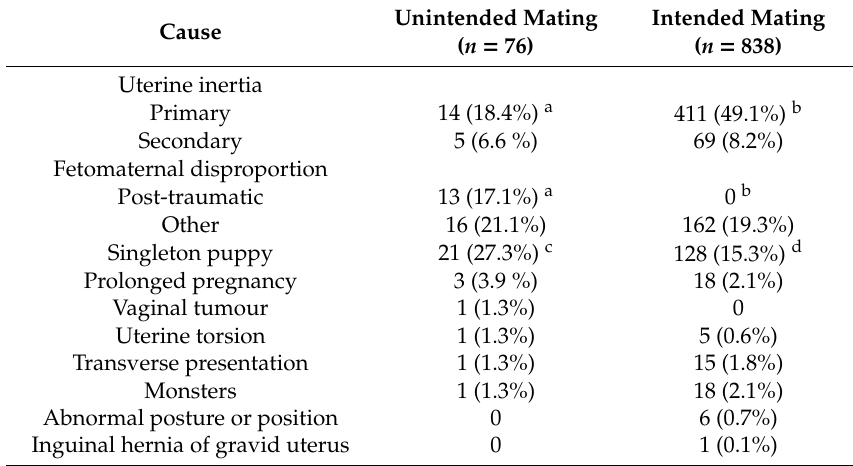
Table 4. Classification of causes (number of cases and percentage) leading to dystocia in 76 bitches pregnant after unintended mating and in 838 bitches mated intentionally ( n = 914). Unintended Mating Intended Mating Cause ( n = 76) ( n = 838) Uterine inertia Primary 14 (18.4%) a 411 (49.1%) b Secondary 5 (6.6 %) 69 (8.2%) Fetomaternal disproportion Post-traumatic 13 (17.1%) a 0 b Other 16 (21.1%) 162 (19.3%) Singleton puppy 21 (27.3%) c 128 (15.3%) d Prolonged pregnancy 3 (3.9 %) 18 (2.1%) Vaginal tumour 1 (1.3%) 0 Uterine torsion 1 (1.3%) 5 (0.6%) Transverse presentation 1 (1.3%) 15 (1.8%) Monsters 1 (1.3%) 18 (2.1%) Abnormal posture or position 0 6 (0.7%) 0